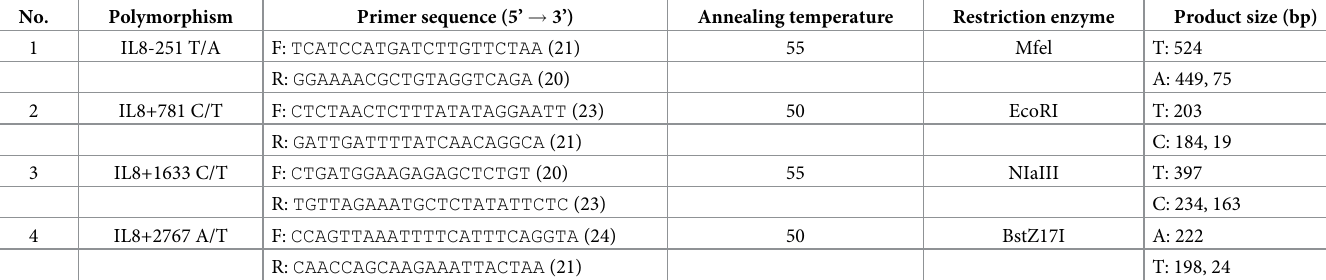
Table 1. Primers for amplification (primer sequence (5’ ! 3’), annealing temperature and restriction enzyme for digestion). No.